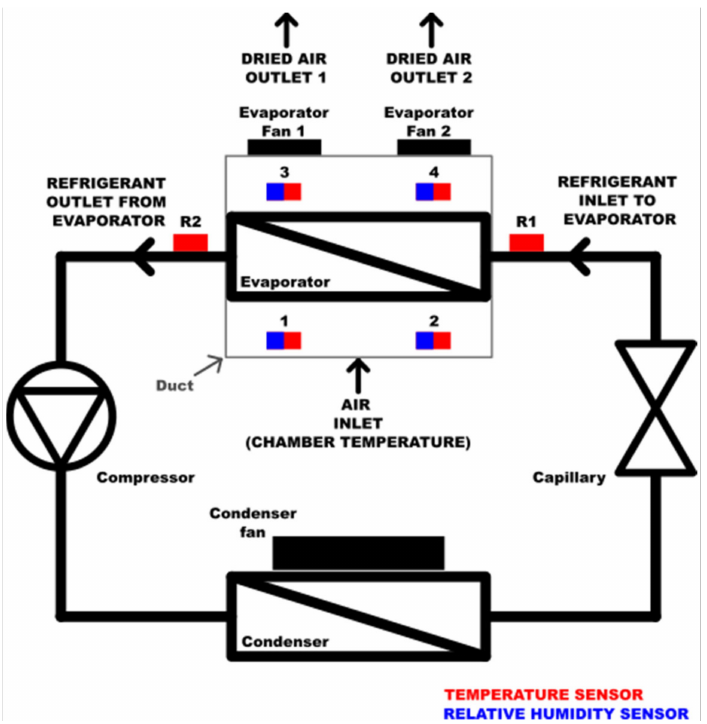
Figure 3. Scheme of the tested device and the arrangement of the measuring probes. The temperature and humidity were measured at four points: two in front of the evaporator (1 and 2) and two behind (3 and 4). The location of the points was selected in such a way as to reflect the real airflow as much as possible and in a manner that was not affected by random factors. Pt 100 temperature probes (range − 100 ◦ C to 450 ◦ C and accuracy of 0.15 ± 0.002) and EE210 relative humidity probes (range 0% to 100% and accuracy of 1.3%) were used during the test. The surface temperature of the pipes before (R1) and after (R2) the evaporator was measured as required by the mathematical model, i.e., complete evaporation, and the determination of specific points of the refrigeration system. The probes attached to the pipes were insulated with a layer of Armaflex (rubber coating insulation) to minimise the impact of external conditions on the sensors. In